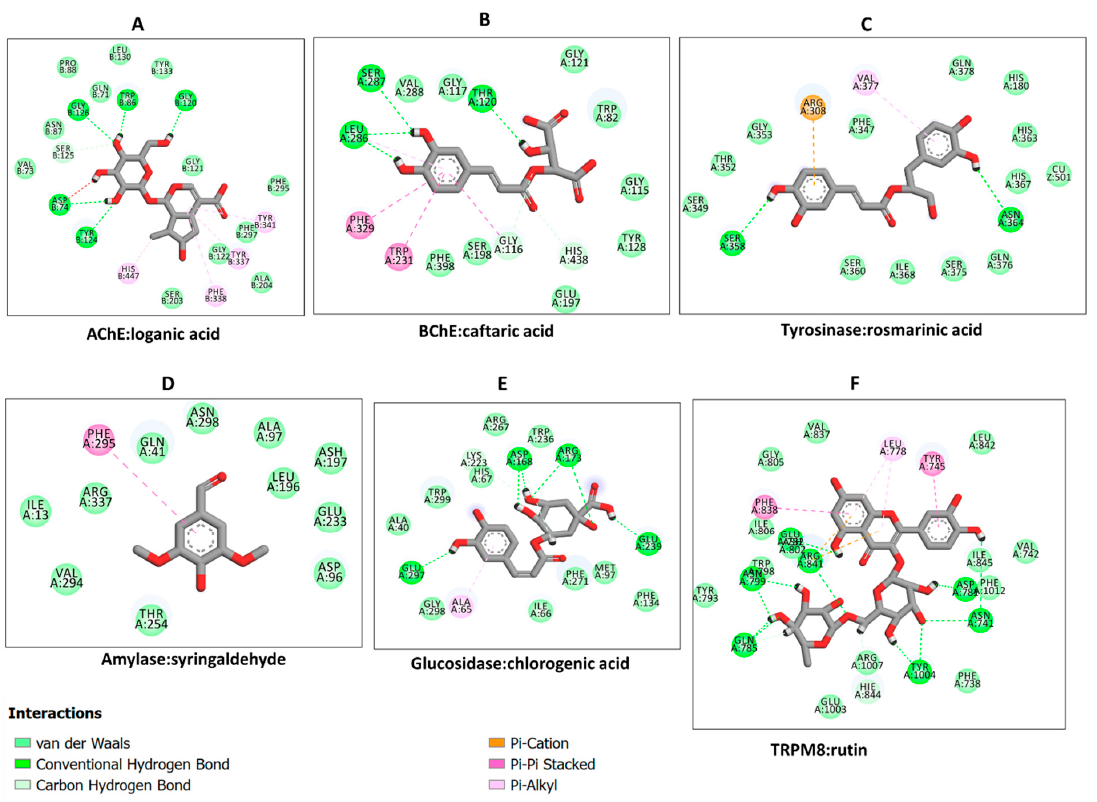
Figure 8. Protein-ligand interactions: ( A ) AChE:loganic acid, ( B ) BChE:caftaric acid, ( C ) tyrosinase:rosmarinic acid, ( D ) α -amylase:syringaldehyde, ( E ) α -glucosidase:chlorogenic acid, and ( F ) TRPM8:rutin.